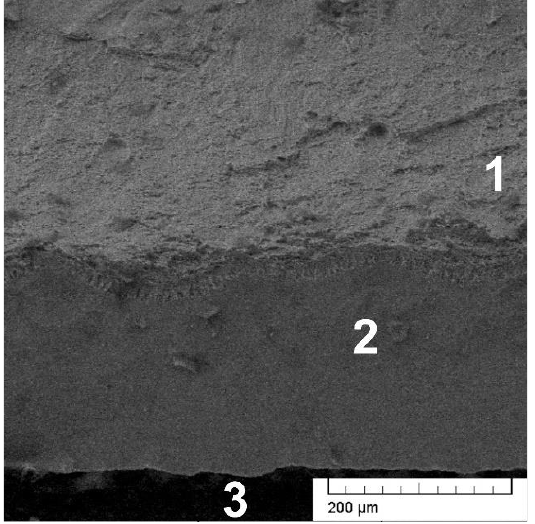
Figure 9. The surface of the fracture in the central area of the weld: 1 — the zone of the fracture; 2 — the non-fusion zone during laser welding; 3 — the core polymer material.